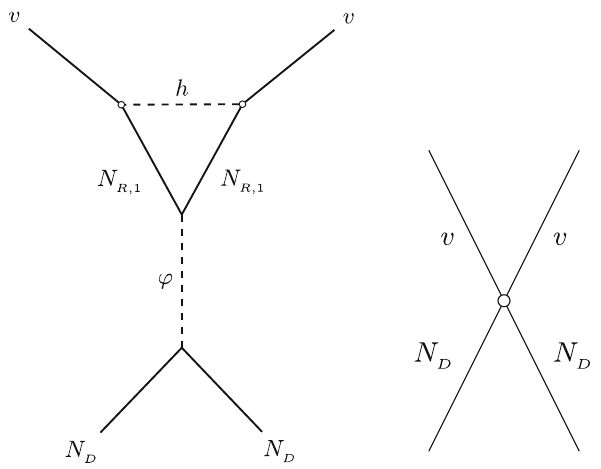
Fig. 4 Left: The Feynman diagram of DM-SM neutrino interaction.